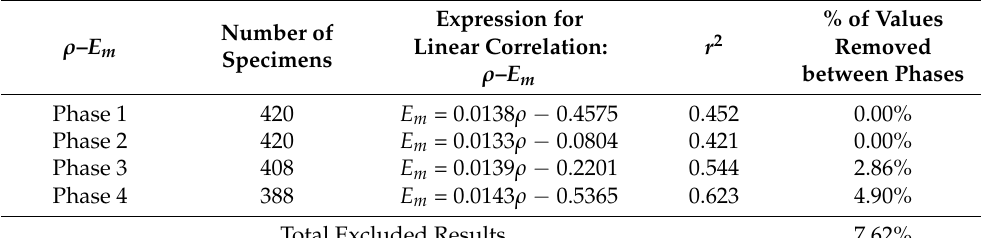
Table 4. Correlation between density ( ρ ) and modulus of elasticity in bending ( E m ).